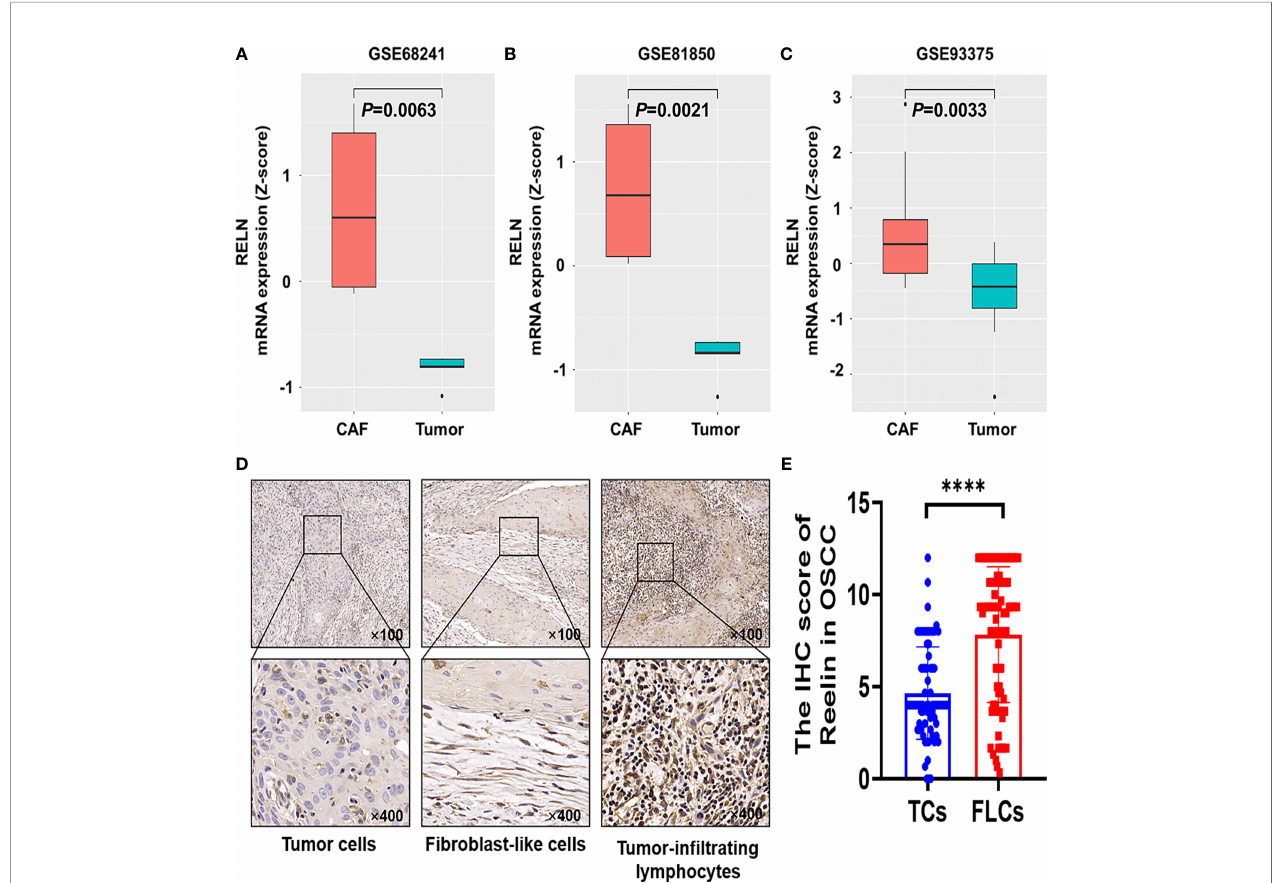
FIGURE 1 | Reelin was upregulated in CAFs compared with TCs derived from OSCC and other several cancers. Enhanced level of RELN CAF compared with RELN TC in breast cancer (A) , pancreatic cancer (B) , and rectal carcinoma (C) using the GEO database. Representative immunohistochemistry staining of Reelin in OSCC, according to TCs, FLCs and TILs (D) . The IHC score of Reelin TC and Reelin FLC in OSCC (E) . **** denoted that differences were considered statistically signi fi cant with p <